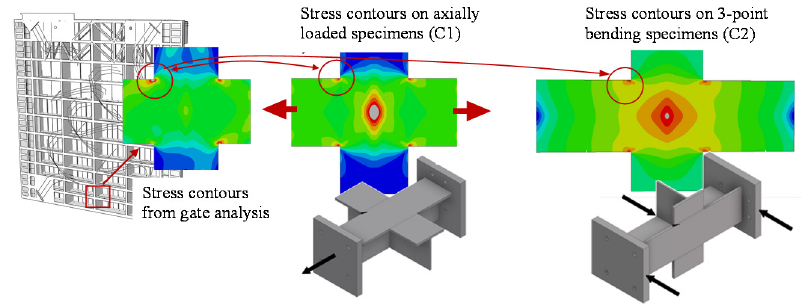
Figure 26. Stresses from the lock gate sub model and test specimen models.